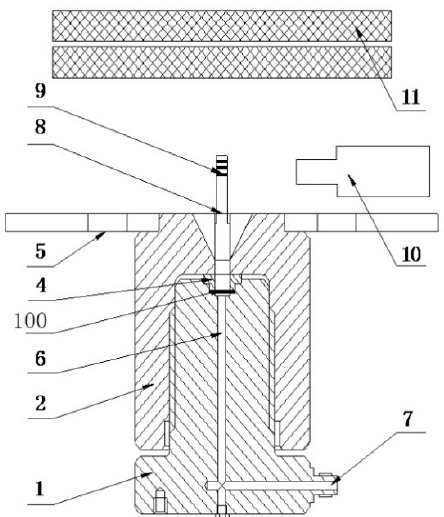
Figure 3. Fixtures: 1 base, 2 cap, 4 upper fixture, 5 handle, 6 oil channel, 7 oil inlet, 8 steel bar, 9 steel bar marker, 10 camera, 11 impact absorber, 100 O-ring seal.